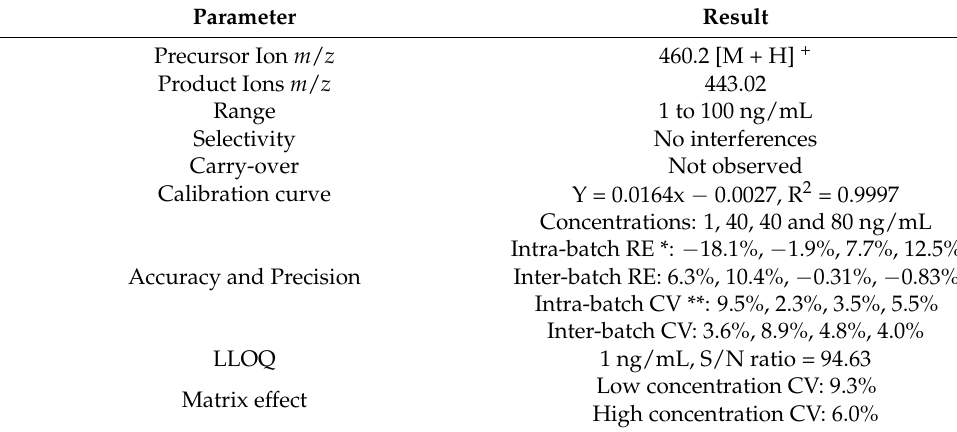
Table 1. Summary of LC-MS/MS validation